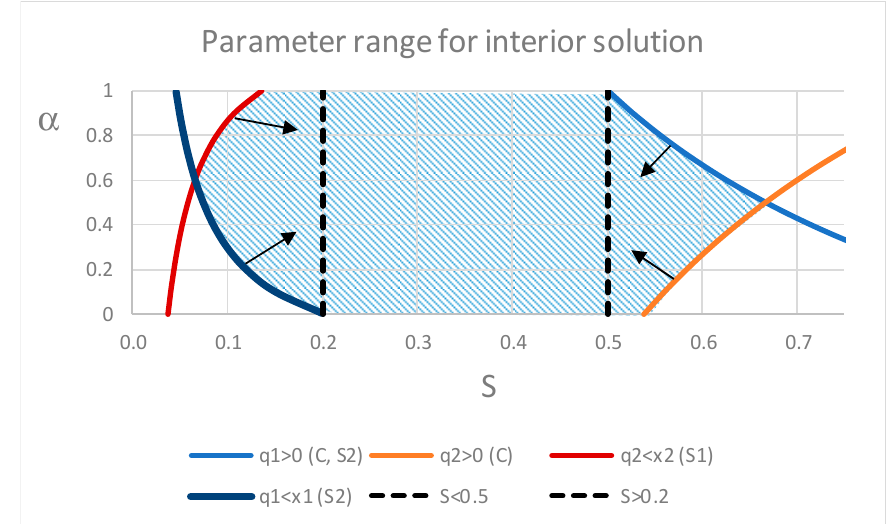
Figure A1. Conditions for interior solutions in Cournot (C), Stackelberg 1 (S1) and Stackelberg 2 (S2)